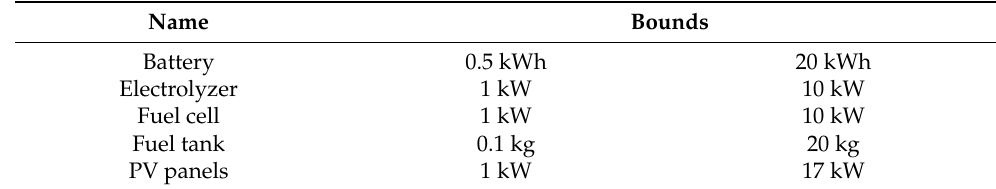
Table 3. Optimization values with their bounds.